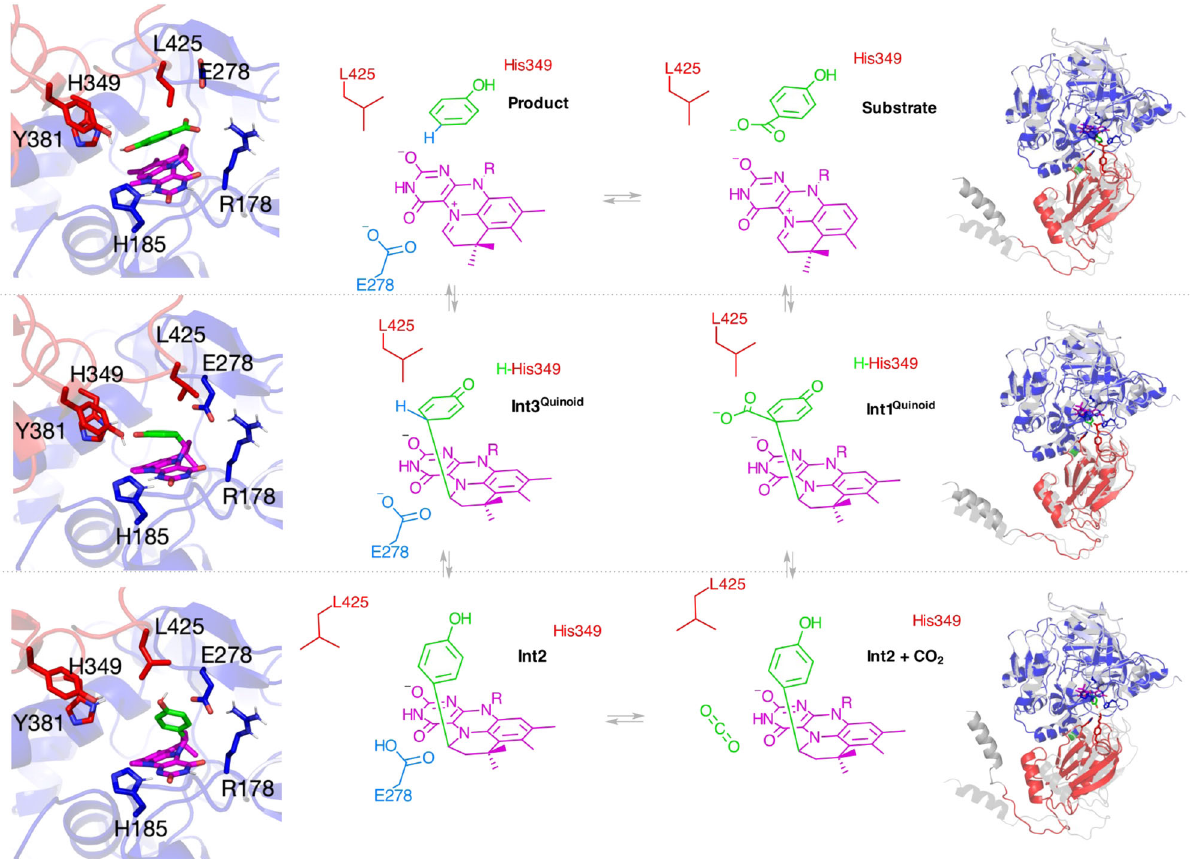
Fig. 5 VdcCD catalysis requires large scale domain motion. Proposed VdcCD mechanism shown with structures to the left showing the lowest energy con fi guration of substrate and intermediates bound in Sh VdcCD active site (prFMN depicted in magenta, and substrate/adducts depicted in green). The structures to the right show the corresponding monomer conformation, overlayed on the closed structure (in translucent grey). Supplementary movie 3 illustrates the domain motions seen between